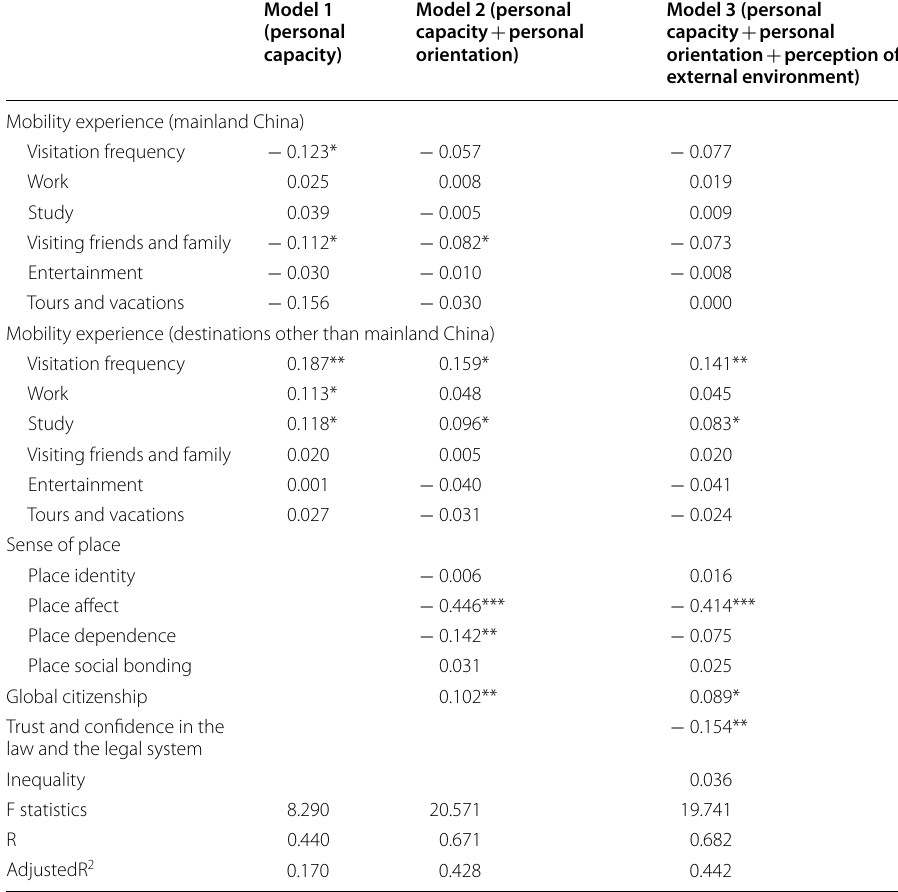
Table 4 Stepwise regression analysis between socio‑political variables and individuals’ intention to migrate